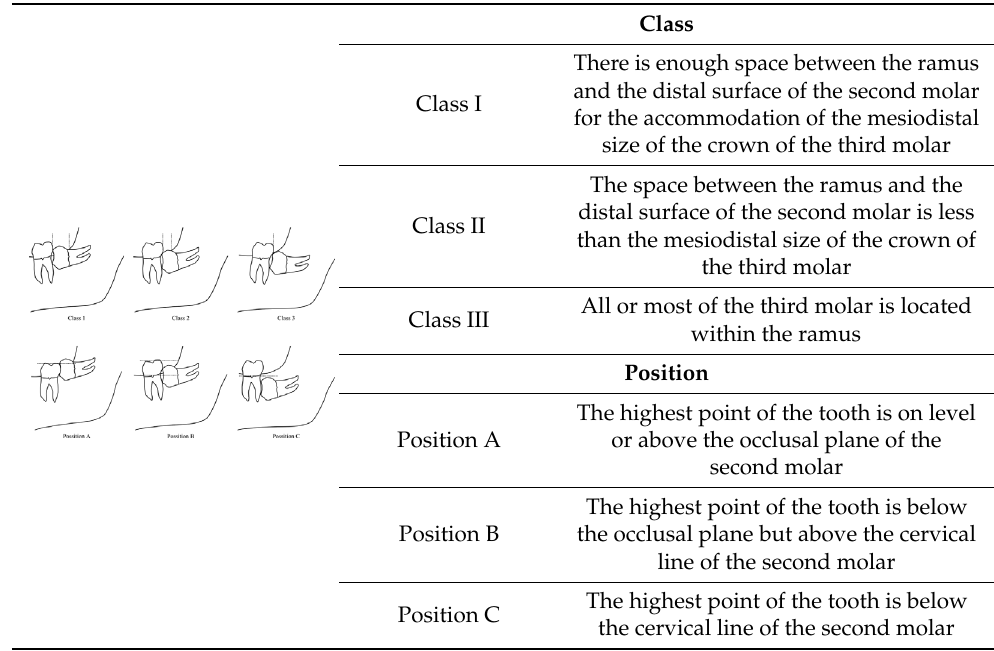
Table 1. Pell and Gregory classification of lower impacted third molars (1933).